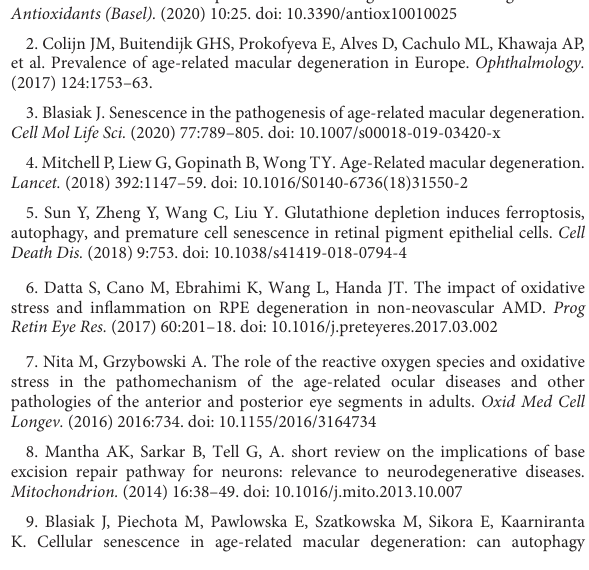
SUPPLEMENTARYFIGURES1 Gene expression distribution across all the samples. (A) Boxplot of the distribution of FPKMs of all the genes in each sample. (B) Density plot of FPKMs of all the genes in each group. (C) PCA plot for each sample based on FPKMs of all the genes. (D) Correlation heatmap plot of each sample based on FPKMs of all the genes. S, H 2 O 2 group; C, Ctrl group; SF, Fullerenol